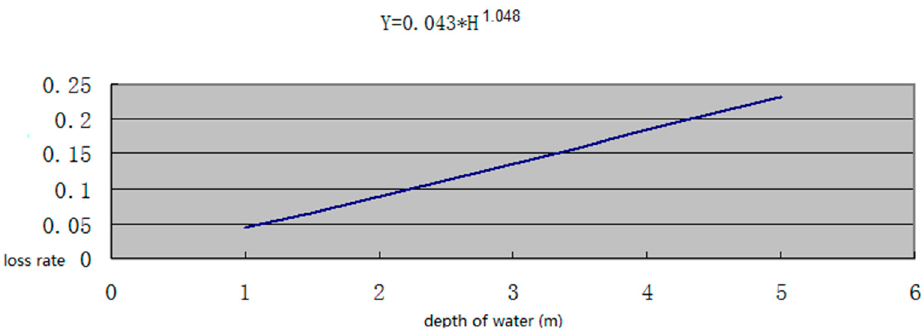
Figure 11. Flood loss rate curve of brick–concrete buildings in the study area.